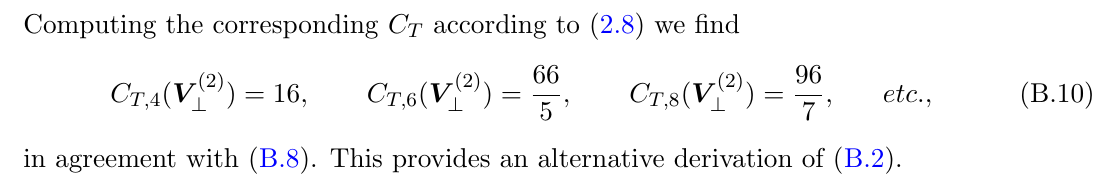
Table 1 . Short multiplets V (1 ; 0) p of OSp(2 ; 6 j 2) that appear in tensor product of p copies of (1 ; 0) doubleton (hypermultiplet)